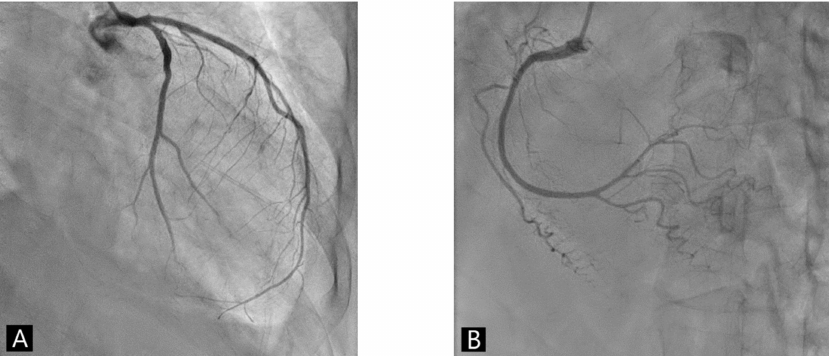
Figure 3. Coronary angiography showed no remarkable atherosclerotic change or stenosis of coronary arteries. ( A ) RAO cranial view. ( B ) LAO cranial